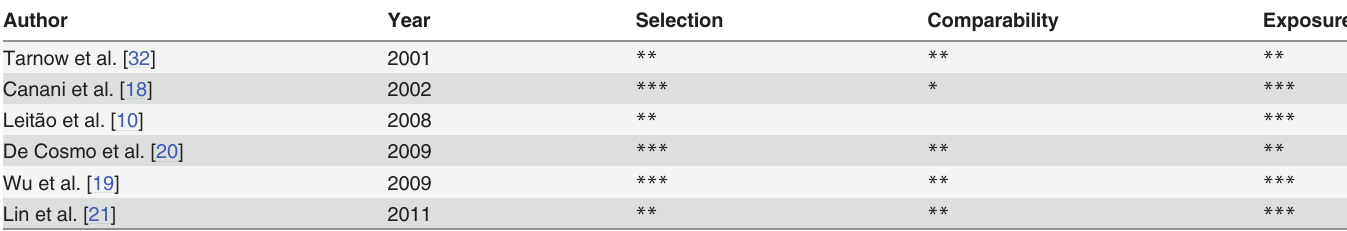
Table 1. Newcastle-Ottawa quality assessment scores for the studies included in the meta-analysis.